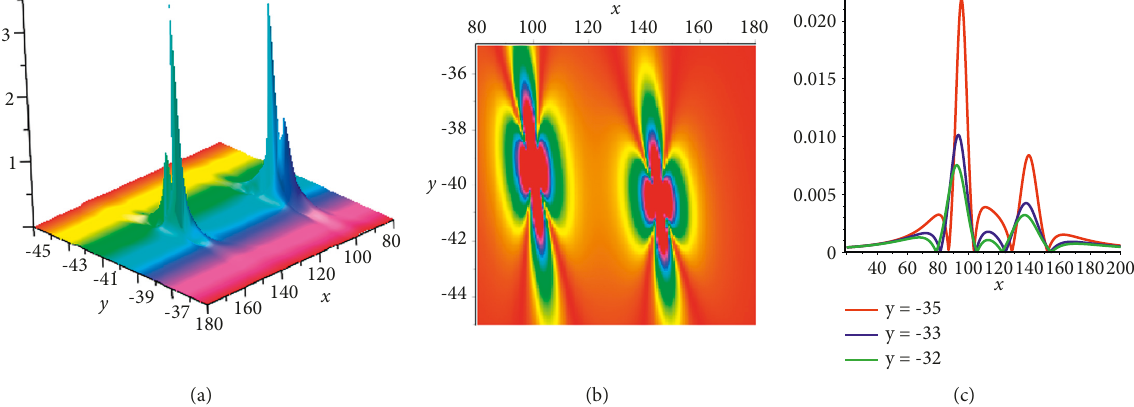
Figure 6: Plot of equation (48) by taking a � c � 1 , b � − 2 . 5 , d � 2 , ϕ